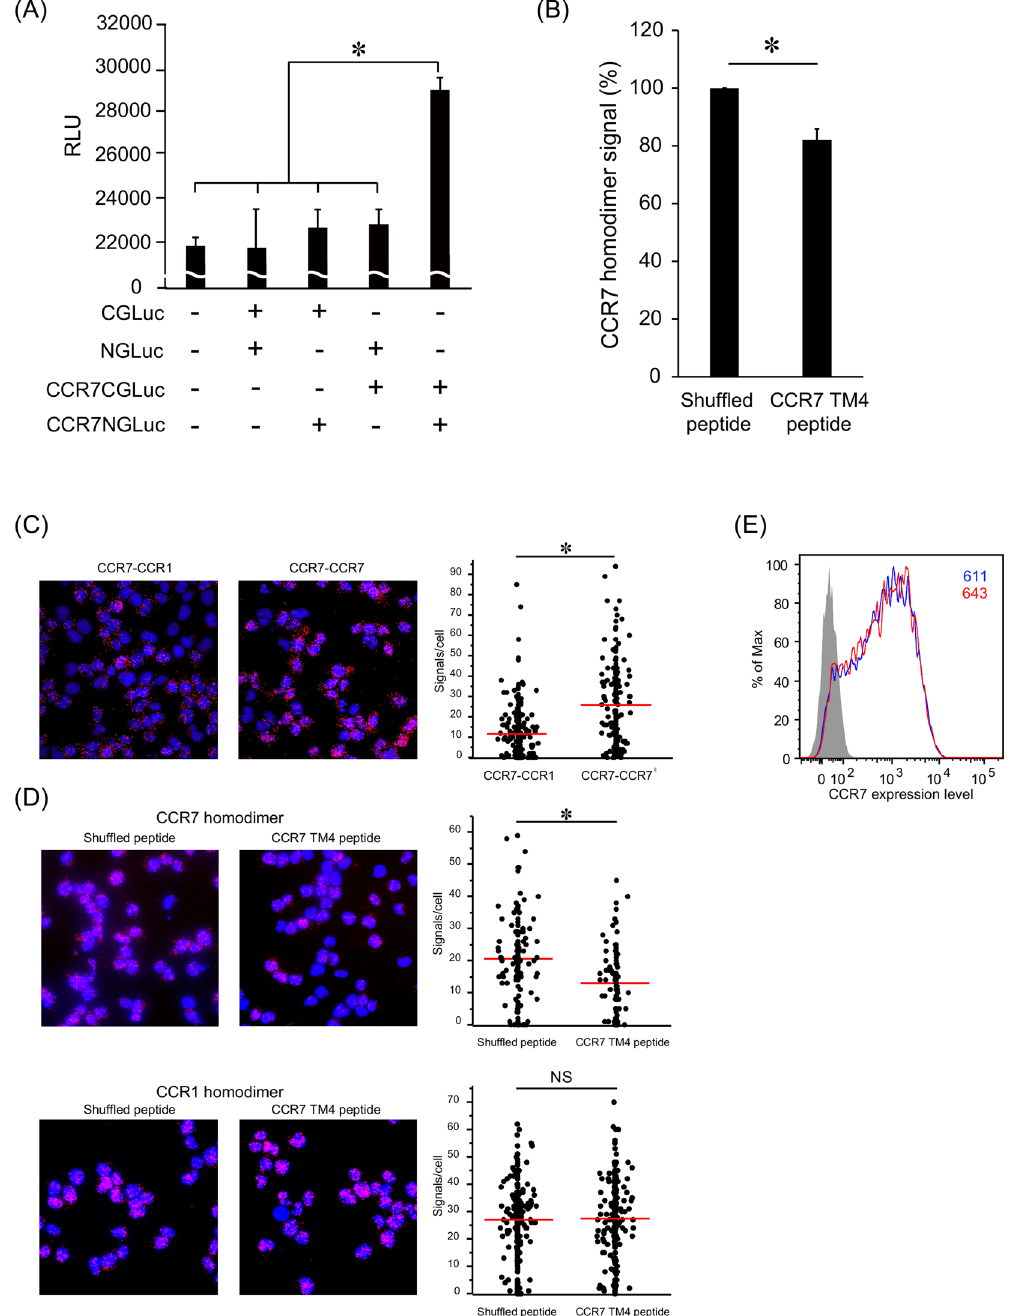
Figure 3. CCR7 homodimers are dissociated by the CCR7 TM4-derived peptide. ( A ) The levels of bioluminescence signals are presented for HEK293T cells transfected with the indicated combinations of CCR7-CGLuc, CCR7-NGLuc, CGLuc and NGLuc plasmids (1.5 μ g each). A representative experiment from at least three independent experiments is shown. Data represent mean ± SD of triplicate samples. * p < 0.05 by one-way ANOVA. ( B ) The levels of bioluminescence signals are shown for cells transfected with combinations of CCR7-CGLuc and CCR7-NGLuc in the presence of the CCR7 TM4 peptide or the shuffled peptide (15 μ g/ ml). Relative luminescence was obtained by normalizing the values against untransfected cells. A representative experiment from at least three independent experiments is shown. Data represent mean ± SD of triplicate samples. * p < 0.05 by Student’s t test. ( C ) The levels of CCR7 homodimer in parental H9 cells were measured by in situ PLA. CCR7-CCR1 heterodimer formation detected by anti-CCR7 mAb-PLA Plus and anti-CCR1 mAb -PLA Minus (left), and CCR7 homodimer formation by anti-CCR7 mAb-PLA Plus and -PLA Minus (right). A representative experiment from at least three independent experiments is shown with the mean number of PLA signals plotted on the vertical axis. * p < 0.05 by Mann-Whitney’s U test. ( D ) CCR7 (top) or CCR1 (bottom) homodimer formation after treatment with the CCR7 TM4 peptide (right panel) or the shuffled peptide (left panel). The number of PLA signals per cell was counted using the Duolink Image Tool software.